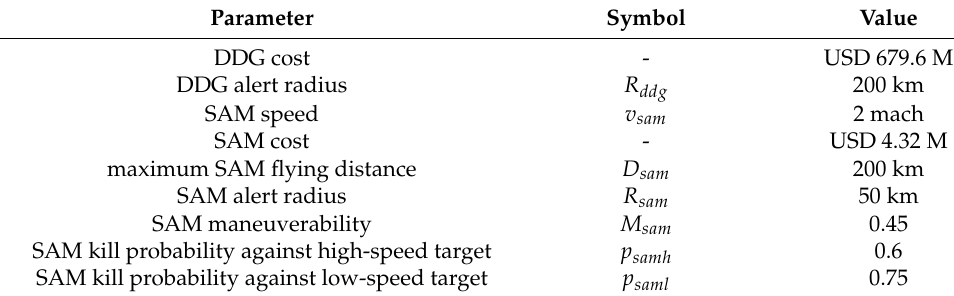
Table 5. Parameters of